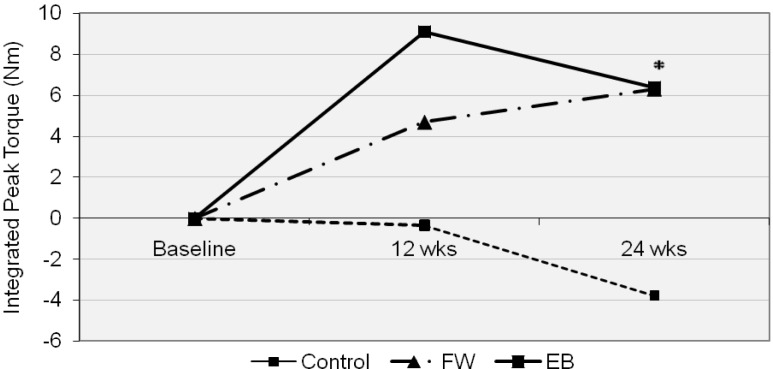
Values are presented as percent change from baseline to 24 weeks. * denotes statistically different from CON (p < 0.05). CON=control group; FW=free weight group; EB=elastic band and free weight combined training group